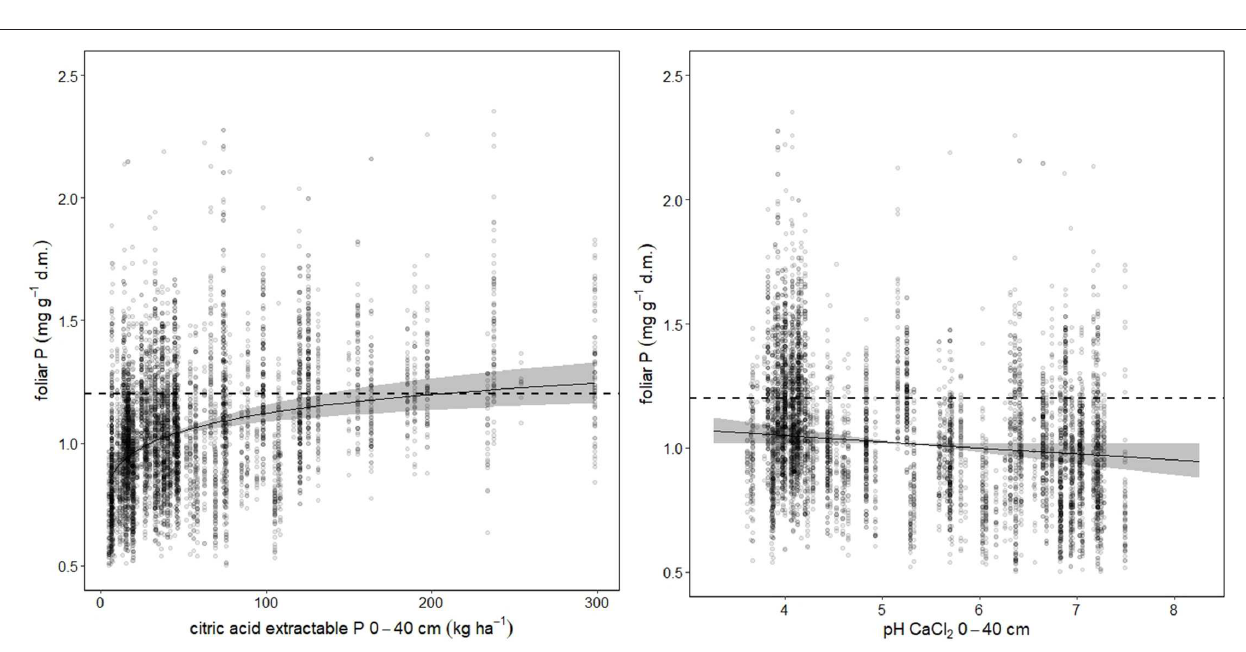
FIGURE 3 | Soil chemistry predictors for foliar P. The dotted lines indicate the lower threshold of normal nutrition according to Göttlein (2015), the gray bands the 95% confidence intervals. Total variance explained is 60.9%, while citric acid extractable P (left graph) accounted for 41.5%, and pH (right graph) for 31.6%.